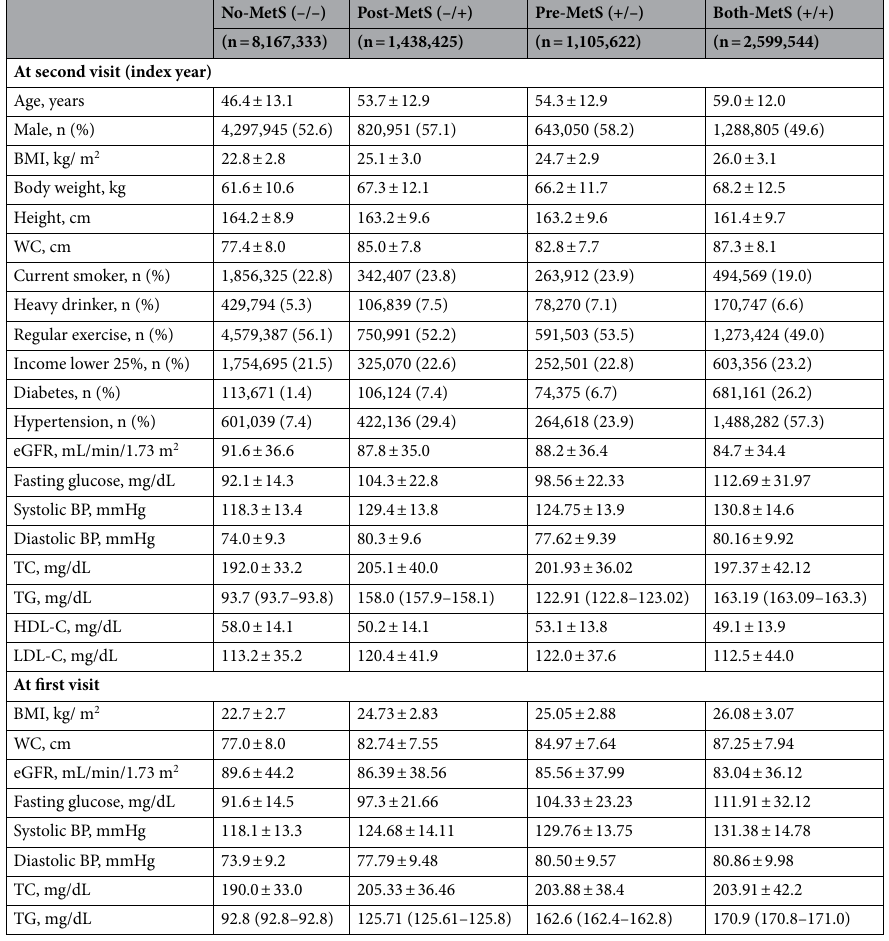
Table 1. Demographics of the study population according the change in MetS components. Data are expressed as the mean ± SD, median value (interquartile range) or n (%). MetS metabolic syndrome, BMI body mass index, WC waist circumference, BP blood pressure, TC total cholesterol, TG triglyceride, HDL-C high-density lipoprotein cholesterol, LDL-C low-density lipoprotein cholesterol, eGFR estimated glomerular filtration